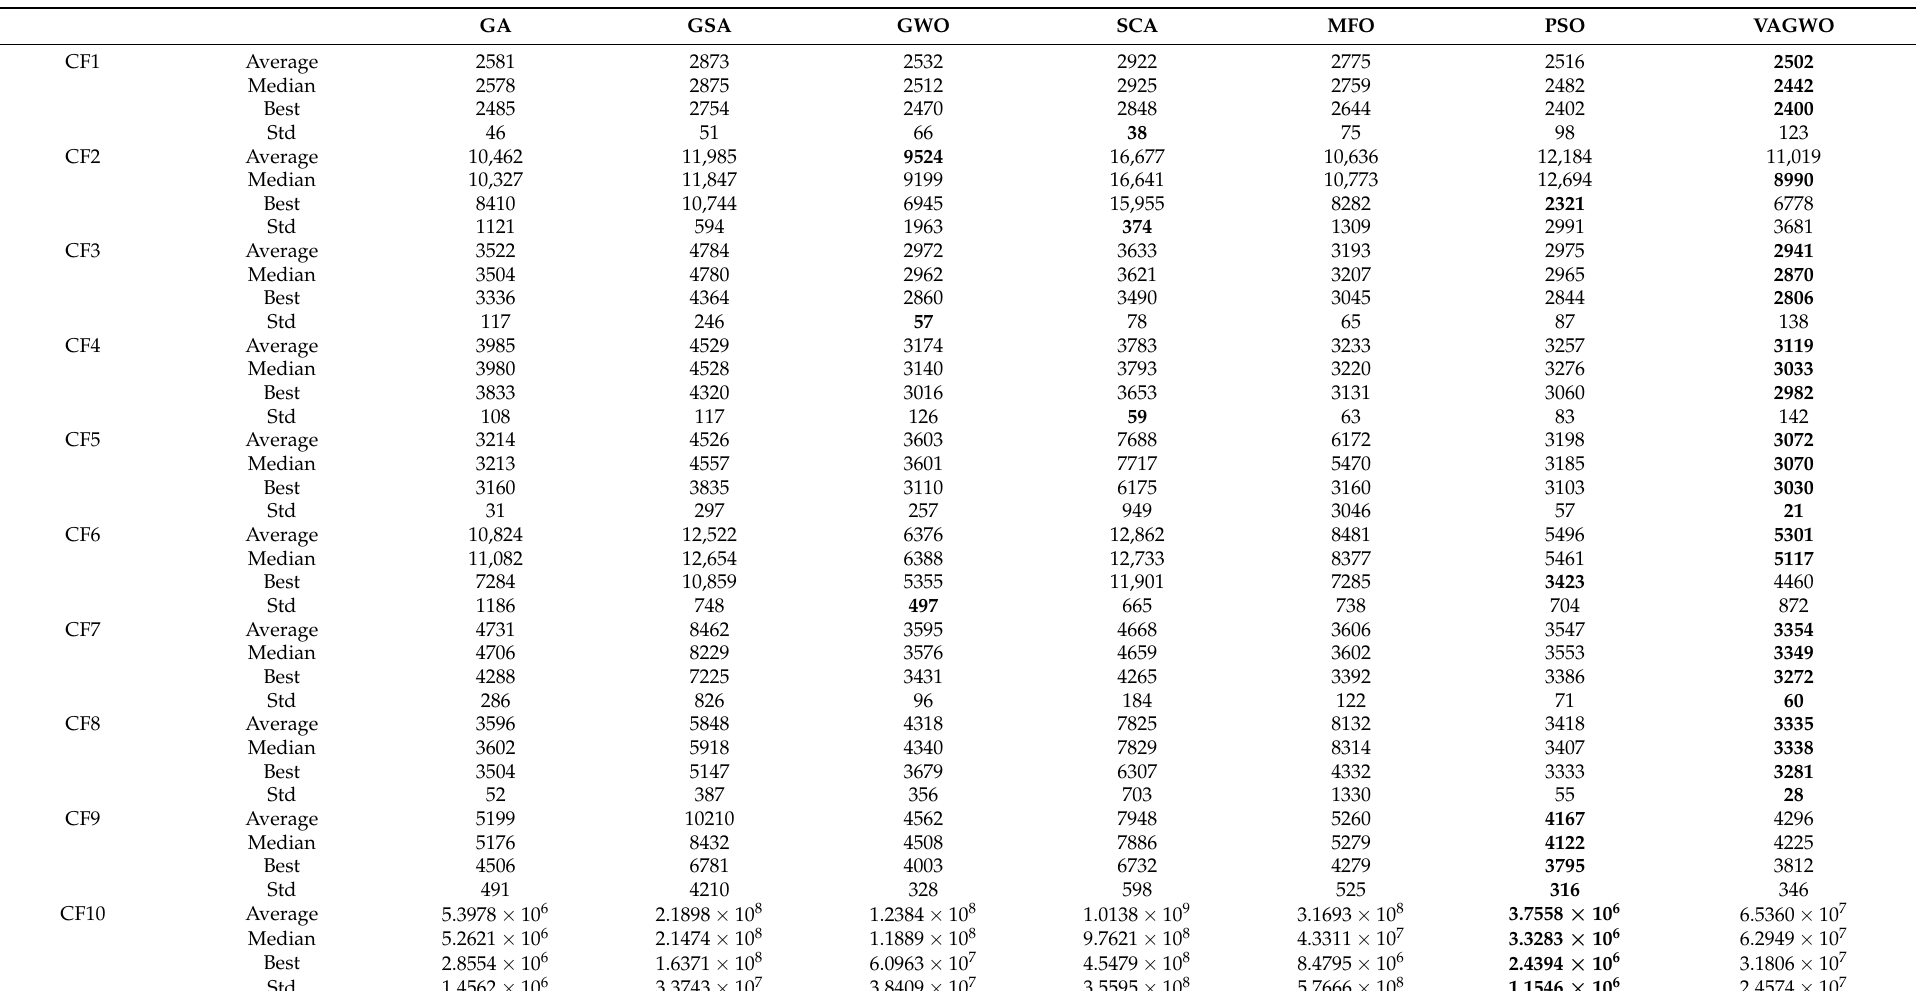
Table 4. The results achieved by the popular algorithms for the composition functions (CFs) from the CEC2017 test suite at D = 50. GA GSA GWO SCA MFO